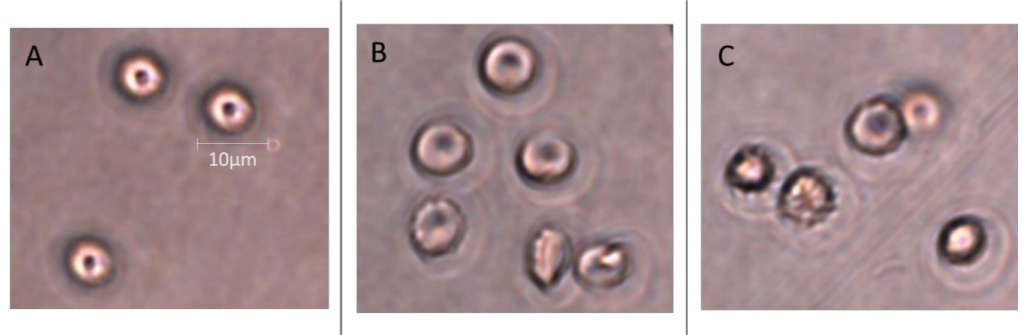
Figure 18. Micrographs of human control erythrocytes ( A ) and the erythrocytes incubated with TBBPA at 25 µ g/mL ( B ) and TBBPS at 100 µ g/mL ( C ) for 48